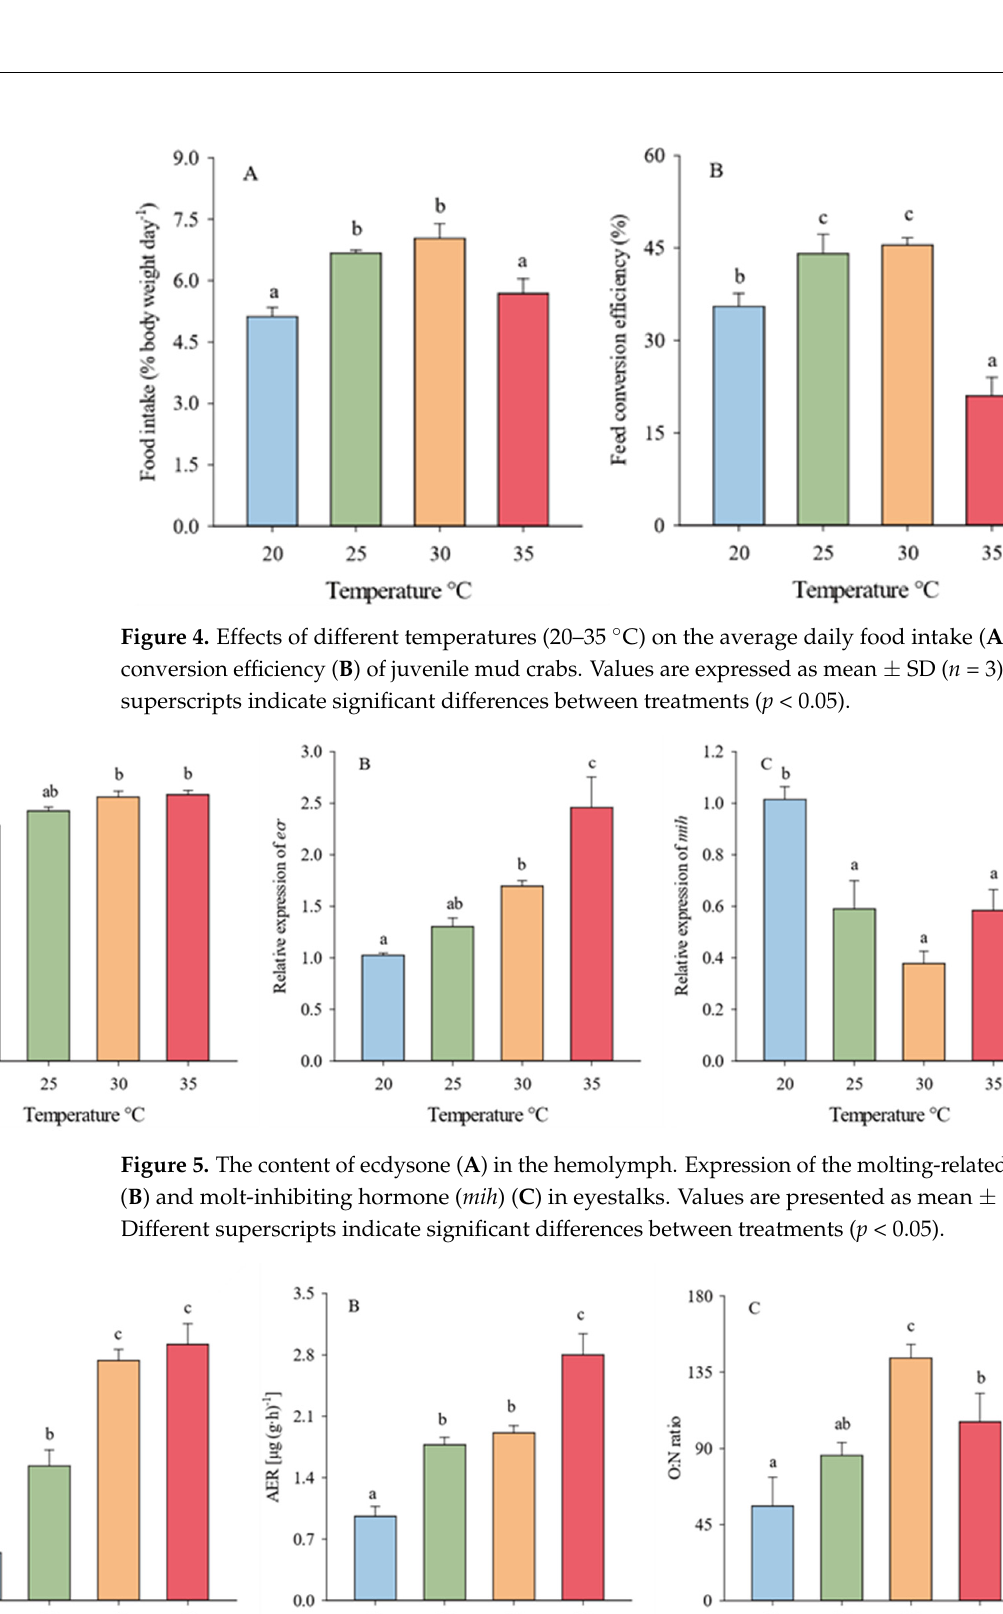
Figure 5. The content of ecdysone ( A ) in the hemolymph. Expression of the molting-related gene ( ecr ) ( B ) and molt-inhibiting hormone ( mih ) ( C ) in eyestalks. Values are presented as mean ± SD ( n = 3). Different superscripts indicate significant differences between treatments ( p < 0.05). Figure 6. Oxygen consumption rate (OCR) ( A ), ammonia excretion rate (AER) ( B ), and oxygen-nitrogen ratio (O: N ratio) ( C ) of juvenile mud crabs at different temperatures (20-35 °C). Values are expressed as mean ± SD ( n = 3). Different superscripts indicate significant differences between treatments ( p < 0.05).